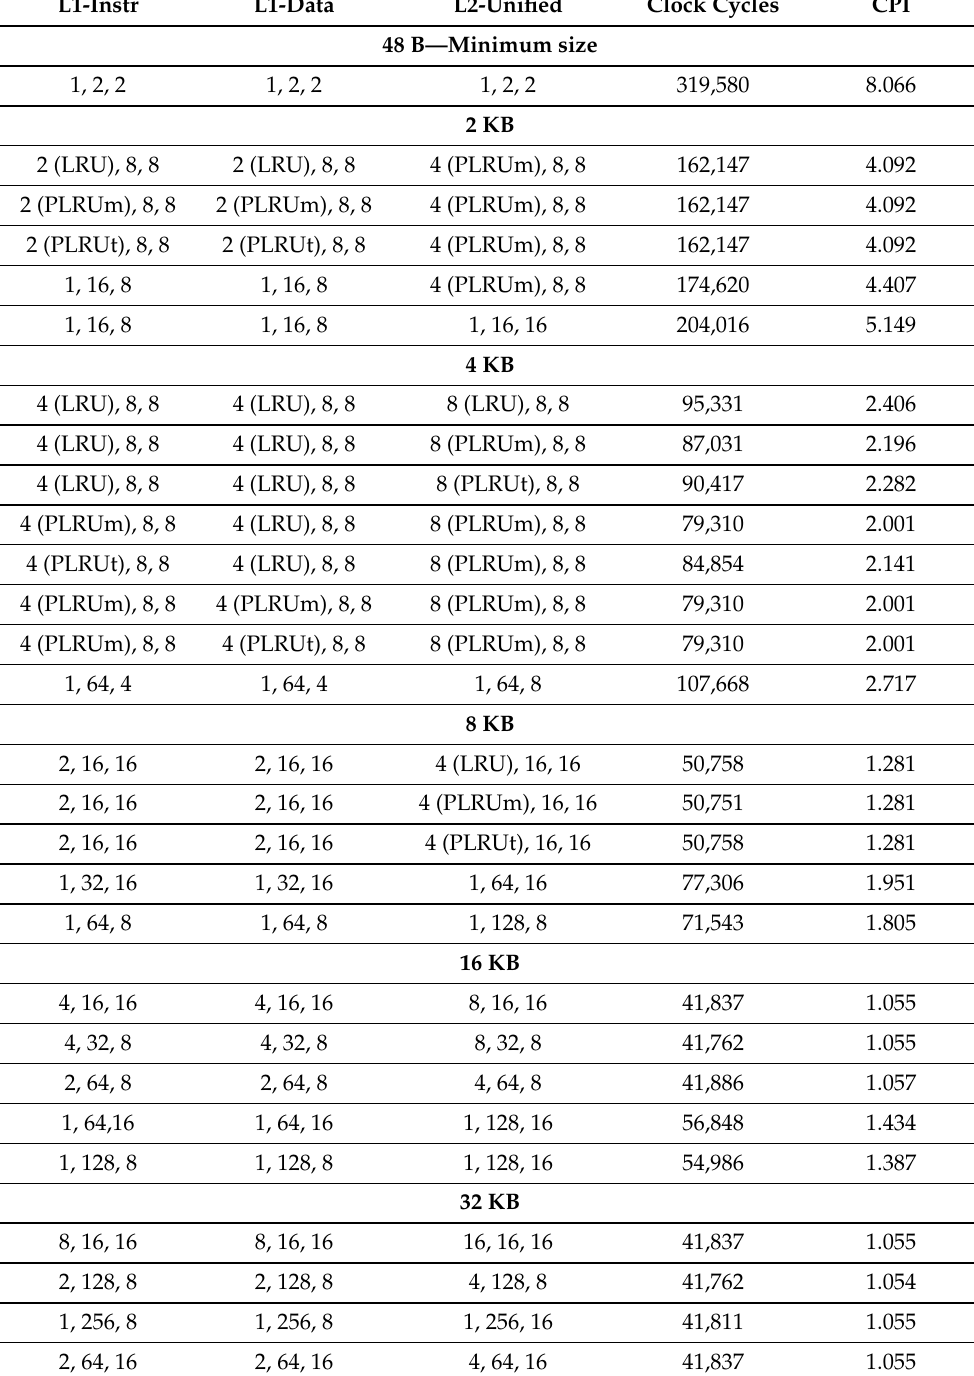
Table 1. Simulation Dhrystone SSRV (IOb-SoC) 32-bit. 100 runs using gcc -O1 optimization. Parame- ters: number of ways (repl. policy), lines, words per